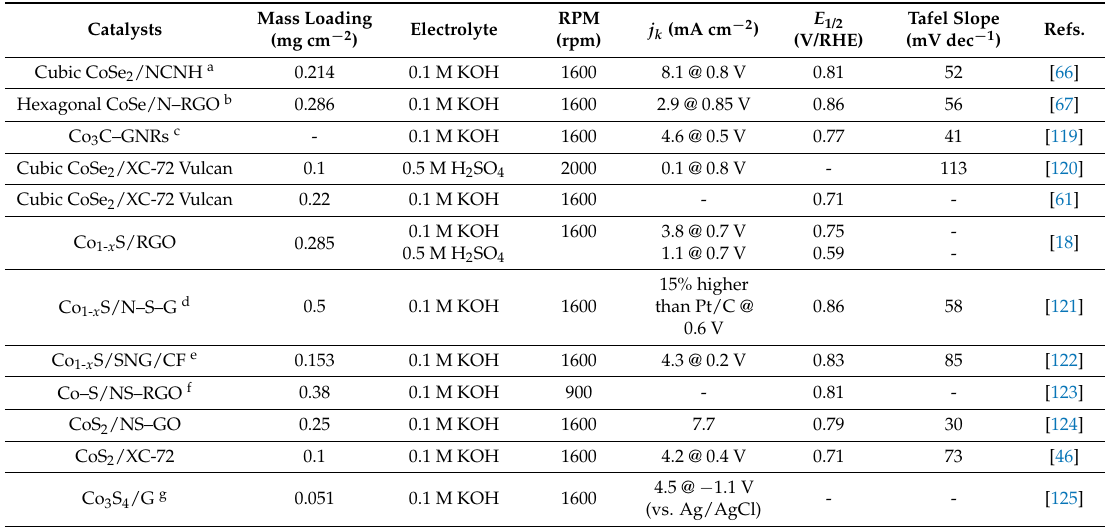
Table 1. Selected Co-based catalyst for the oxygen reduction